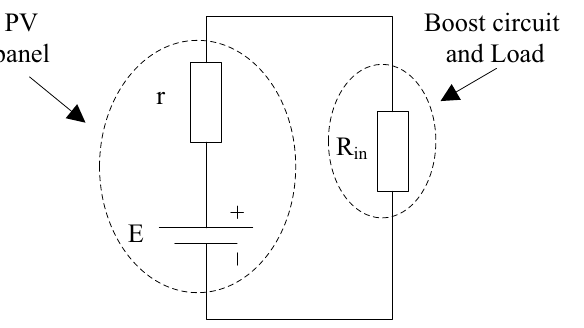
Figure 2. Equivalent diagram of the main circuit of the photovoltaic power generation